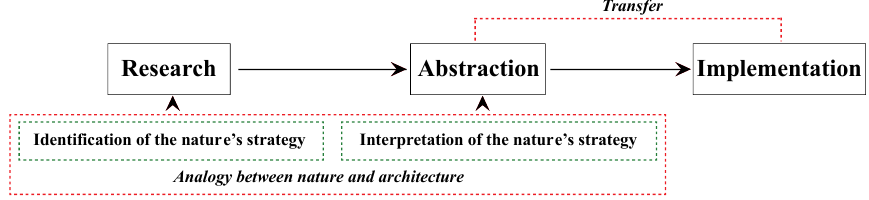
Figure 9. The three steps and two transitions of biomimetic design process: the selection of a biological role model, the translation of biological principles to design contexts and the implementation of a biomimetic application.